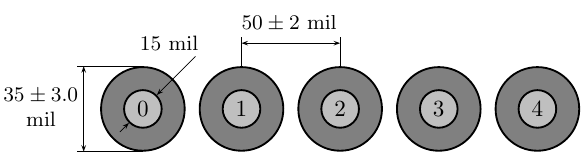
Figure 2: Cross-section of the ribbon cable for the first ap- plication test case. The deviations indicated are inteded as standard deviations of a Gaussian